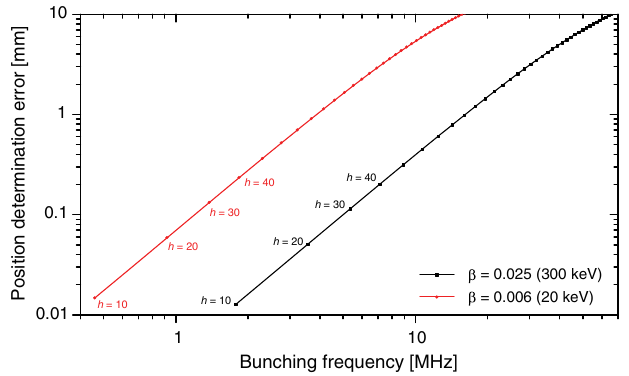
FIG. 24. Beam position determination error as a function of bunching frequency at (cid:1) ¼ 0 : 025 (300 keV) and (cid:1) ¼ 0 : 006 (20 keV) for a pickup with 50 mm radius and a single frequency ¼ h (cid:5) f response at f rf rev